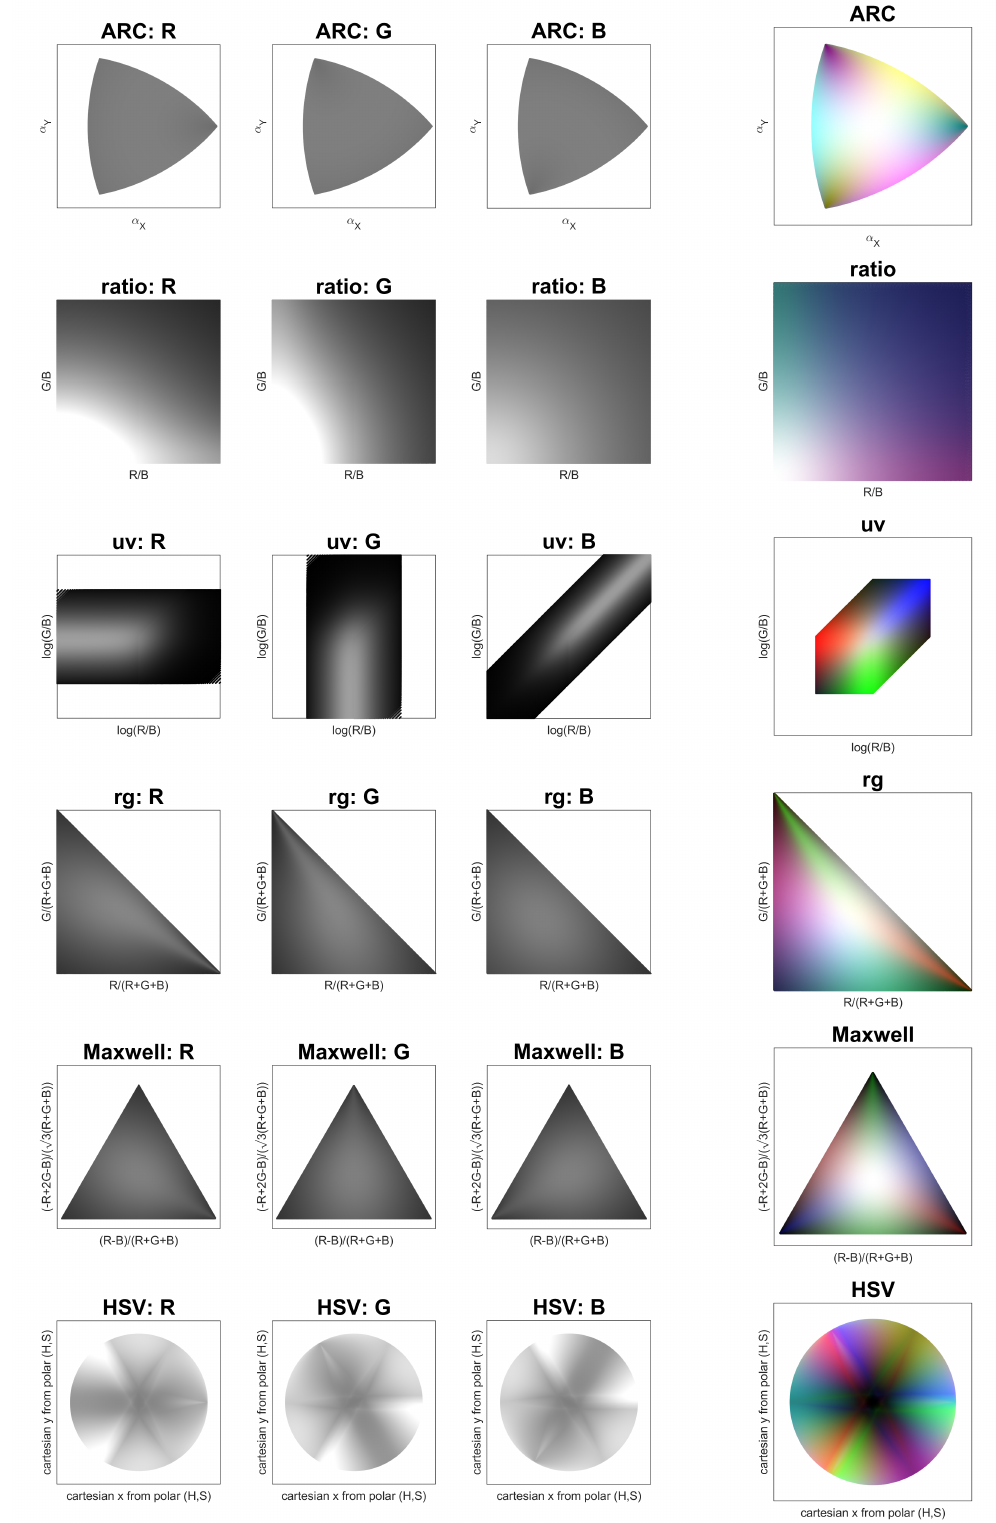
Figure 6. Visual representation of how perturbations on various RGB points map as changes in different chromaticity diagrams. The first three columns present three distortions independently (rotation of R, G, and B), for which flat values close to gray indicate better stability. The last column combines the three pieces of information for a qualitative evaluation of the strongest color